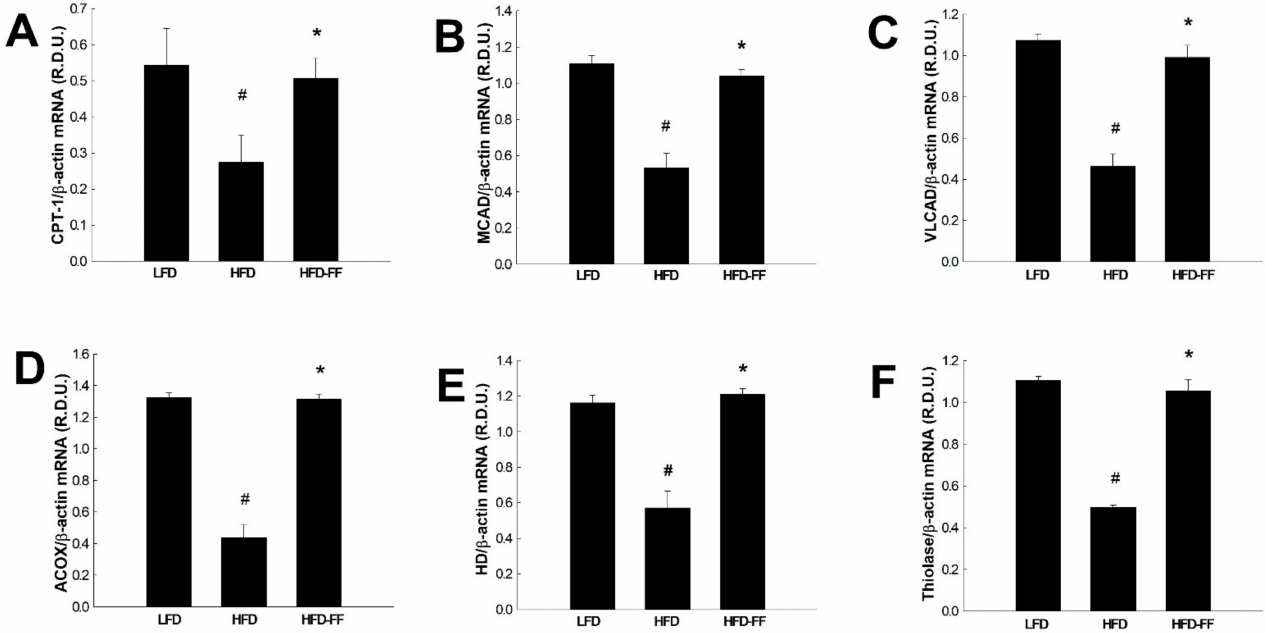
Figure 5. Effects of fenofibrate on visceral adipose tissue expression of genes related to fatty acid β -oxidation in HFD-fed female OVX mice. OVX C57BL/6J mice were fed an HFD or an HFD supplemented with fenofibrate (HFD-FF, 0.05% w / w ) for 21 weeks. The mRNA expression of ( A ) CPT-1, ( B ) MCAD, ( C ) VLCAD, ( D ) ACOX, ( E ) HD, and ( F ) thiolase in visceral adipose tissues. All values are expressed as the mean ± SD ( n = 8/group). # p < 0.05 compared with LFD, * p < 0.05 compared with HFD. ACOX, fatty acyl-CoA oxidase; CPT-1, carnitine palmitoyltransferase I; HD, enoyl-CoA hydratase/3-hydroxyacyl-CoA dehydrogenase; MCAD, medium-chain acyl-CoA dehydrogenase; VLCAD, very long-chain acyl-CoA